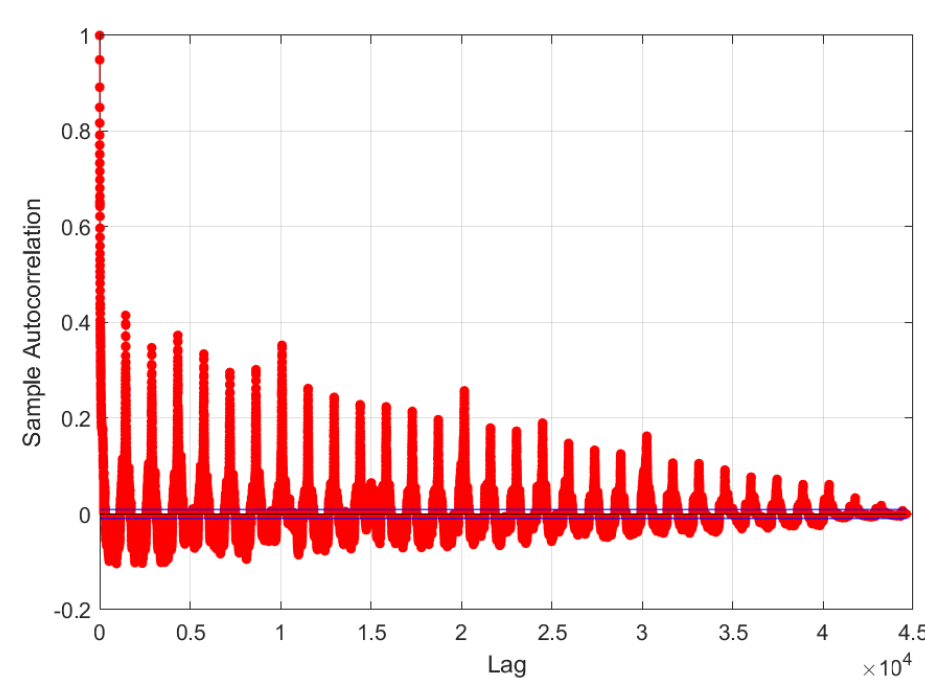
Figure 3. WASK dataset: data autocorrelation